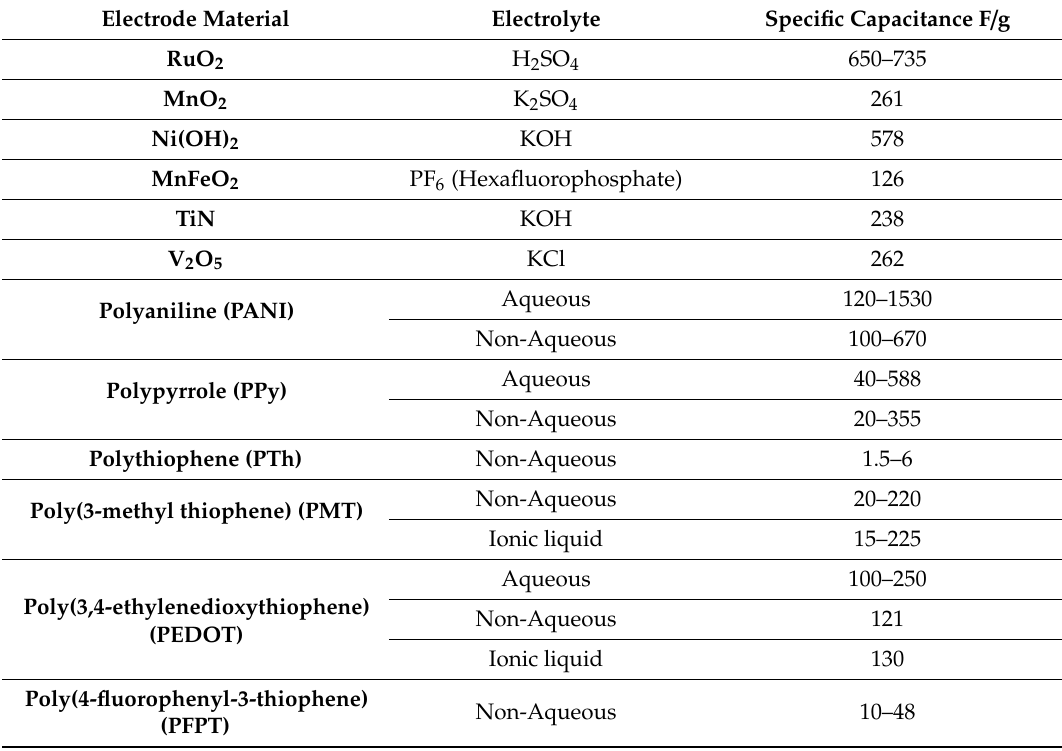
Di ff erent pseudocapacitive electrode materials with their electrolytes and specific capacitance